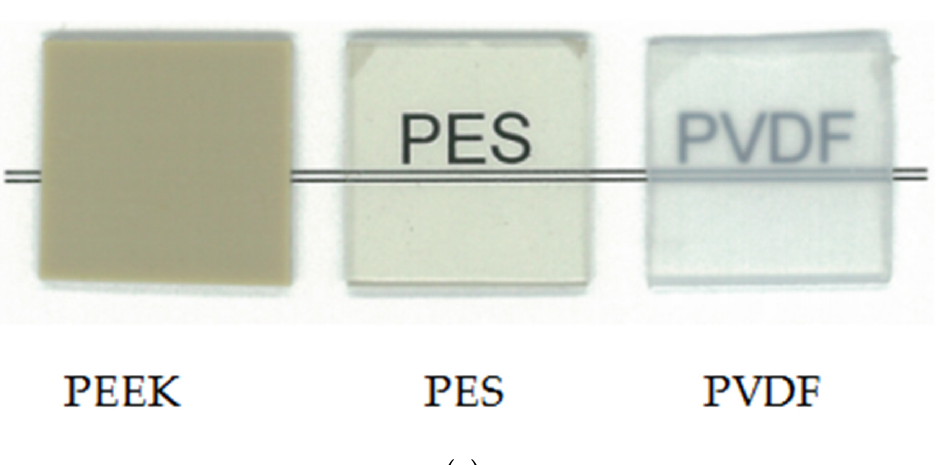
deformation, the Nickel-titanium (Ni-Ti) wire had a typical load-deflection curve with no permanent deformation, while SEP wires had the opposite results. Figure 2c displays the bending stress-deflection curves of the specimens. Bending load at 2.0 mm deflection in the three-point test is shown in Figure 2d. PEEK had the greatest flexural load in all of the SEPs. Figure 2e indicates the permanent deformation after the 2.0 mm bending load. Perpetual deformation has not been found in Ni-Ti specimens. On the contrary, less deformation has been observed in SEP samples (PEEK, 0.2 mm; PES, 0.1 mm; PVDF, 0.3 mm). Figure 2f indicates creep deformation of SEP wires after the bending creep test. Among the SEPs, PEEK wires had less creep deformation (less than 1.0 mm deformation after 1 month of bending at 37 ◦